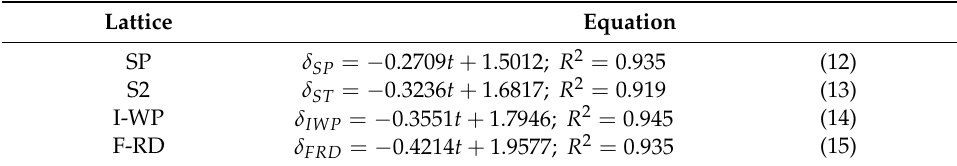
Figure 11. Z -axis deformations of SPSs with different TPMS lattice cores. Table 9. Linear approximations of the deformation. Table 9. Linear approximations of the deformation.